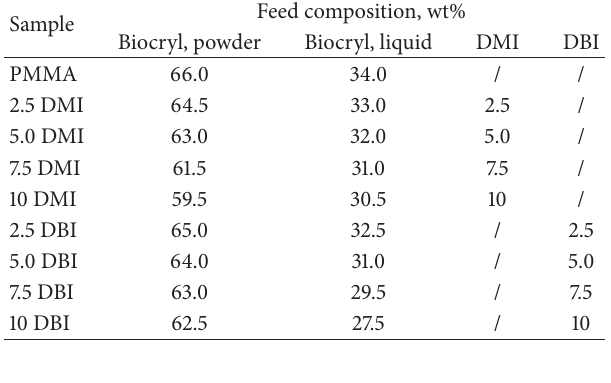
Table 1: Feed composition of synthesized denture base materials.